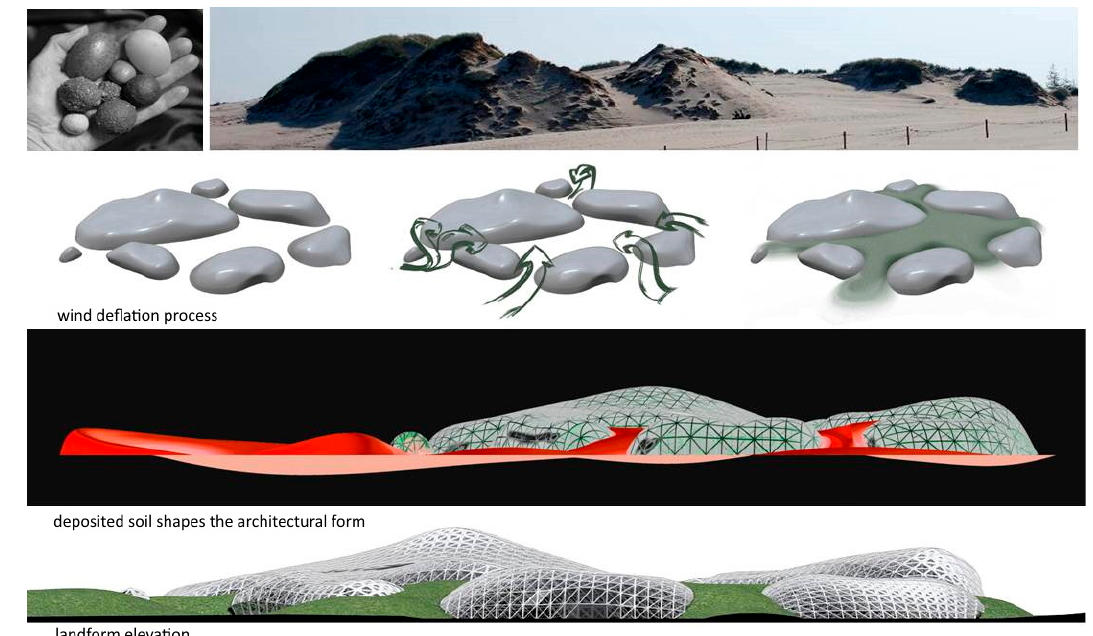
Figure 1. Wind deflation and recreation: Wind deflation analysis—design concept development (Michał Czapiewski).